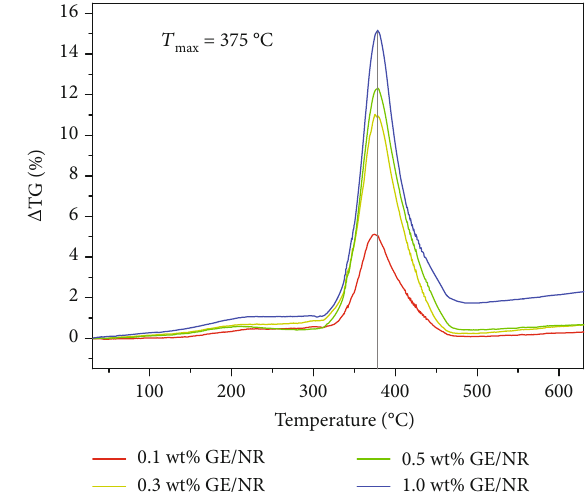
Figure 3: Δ TG curves collected under 5 ° C · min -1 for GE/NR composites with di ff erent GE loading. The dotted line indicates the temperature of maximum Δ TG